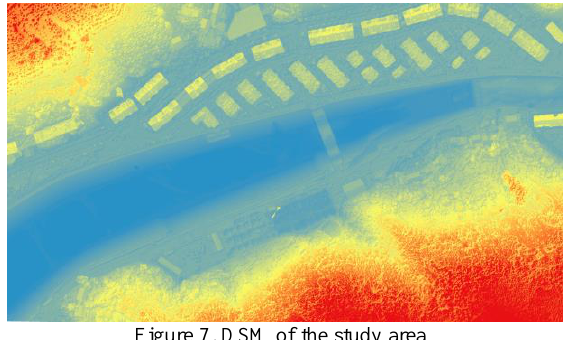
Table 1. Residual of ground control points